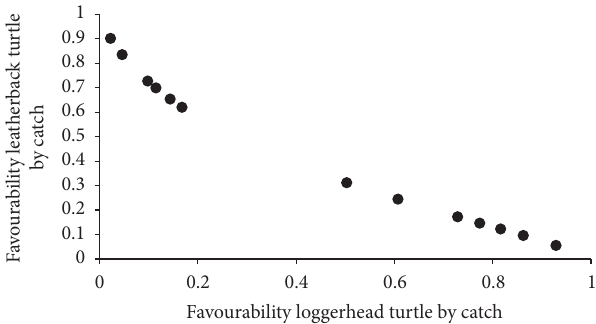
Figure 3: Favourability of obtaining at least one leatherback turtle bycatch in a particular year in function of the average NAO in previous year versus the favourability to obtain a major number of loggerhead turtles bycatches (in the LLHB gear fisheries south of 40 ∘ N) in function of the average NAO in the previous